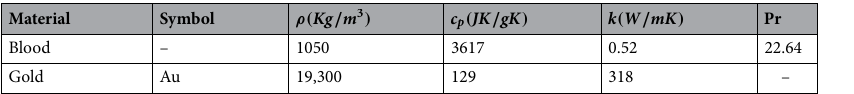
Figure 12. Comparison of obtained results with the results of Sheikh et al 38 , when φ